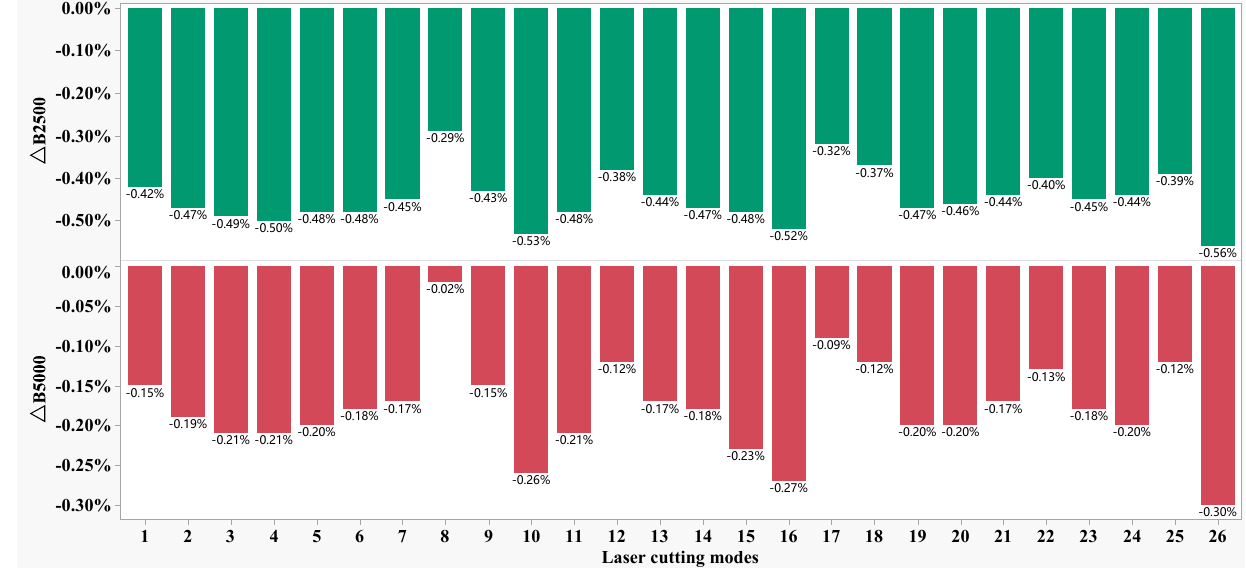
Figure 4. Δ B m distribution under the various laser cutting parameters. Figure 4. ∆ B m distribution under the various laser cutting